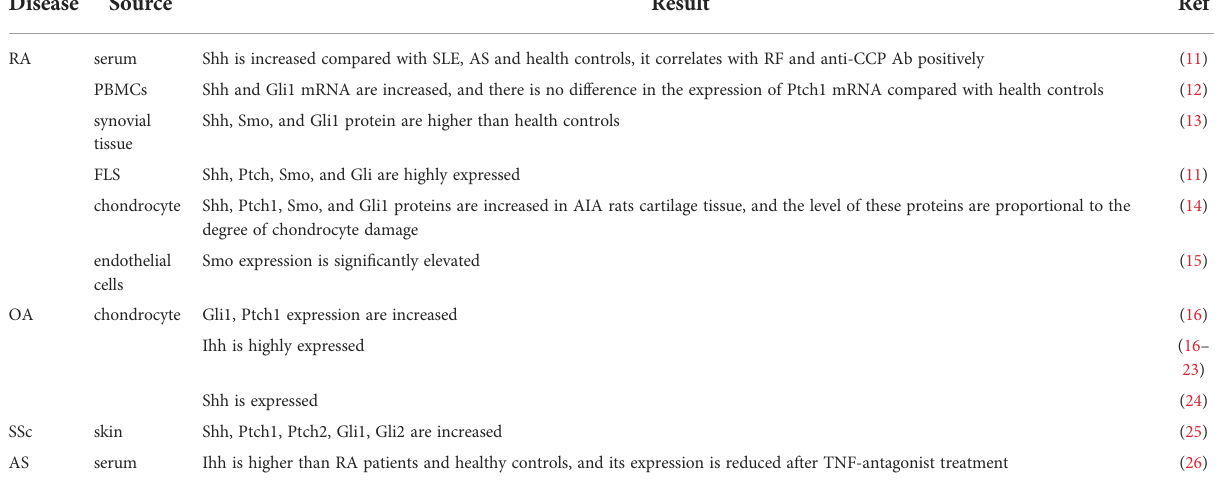
TABLE 1 The expression of Hedgehog signaling in rheumatic diseases.